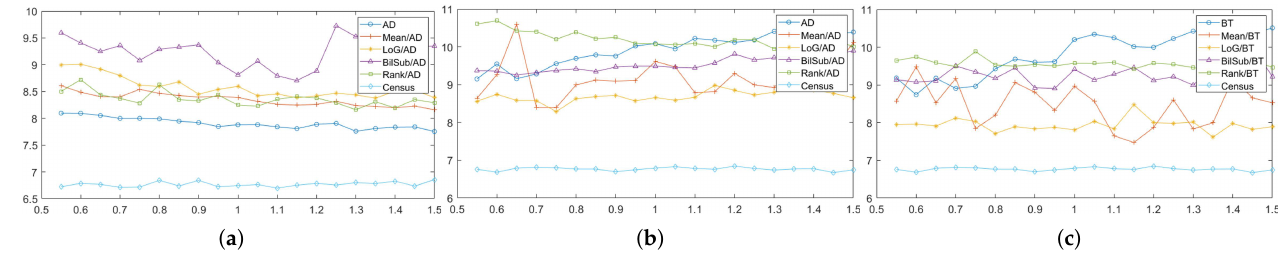
Figure 23. Errors of combinations of cost and image filter using the SGM and GC stereo methods, according to the variation of the image’s gain parameter. ( a ) SGM/AD. ( b ) GC/AD. ( c )